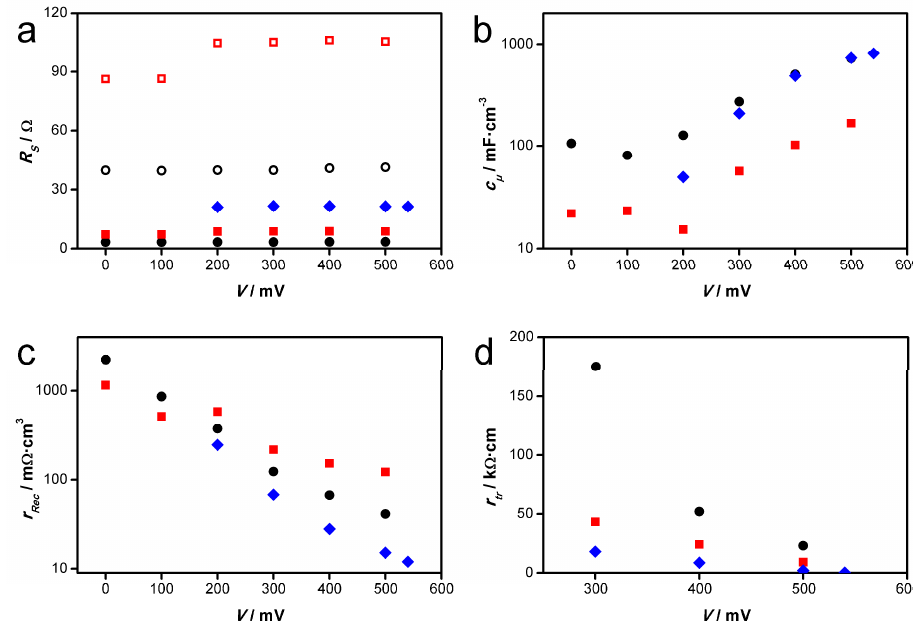
Figure 10. EIS fitting results. ( ■ ) Flexible DSSC module “1”. ( ● ) Flexible DSSC module “2”. ( ♦ ) Flexible small-scaled DSSC. Open symbols: Estimated series resistances R S per module cell. ( a ) series resistance R S ; ( b ) chemical capacitance c µ ; ( c ) recombination resistance r rec ; ( d ) transport resistance r tr .